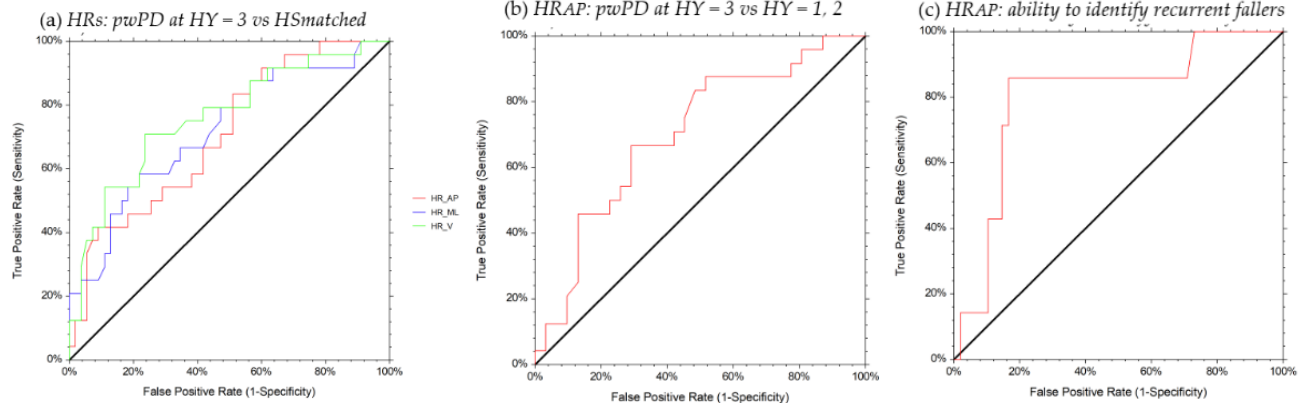
Figure 3. ROC curves for the HRs in identifying pwPD vs. HSmatched, pwPD at HY = 3 from milder HY and recurrent fallers. The red line represents the HR AP , the blue line the HR ML , and the green line the HR V .